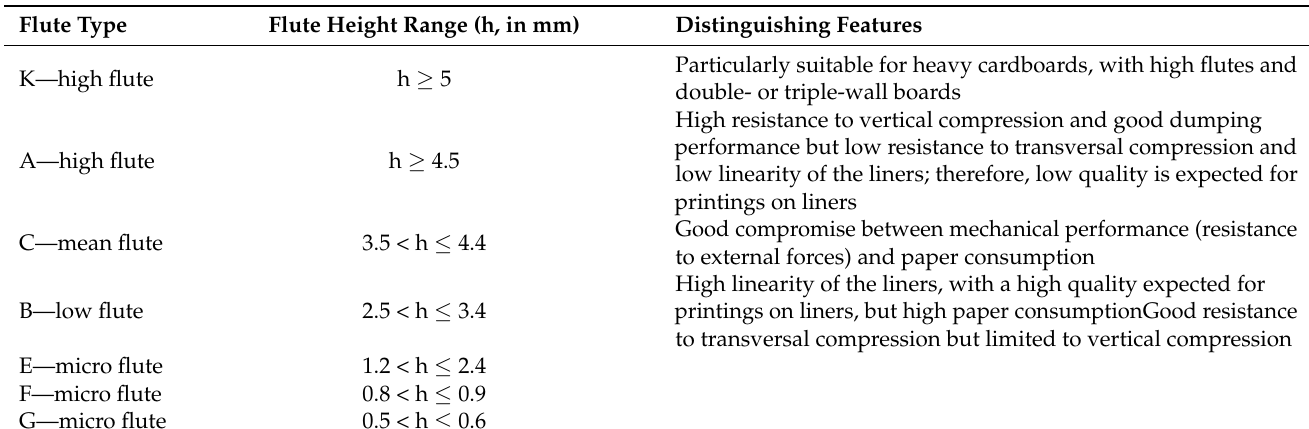
Table 1. Main kinds of flutes, general height ranges, and most distinguishing